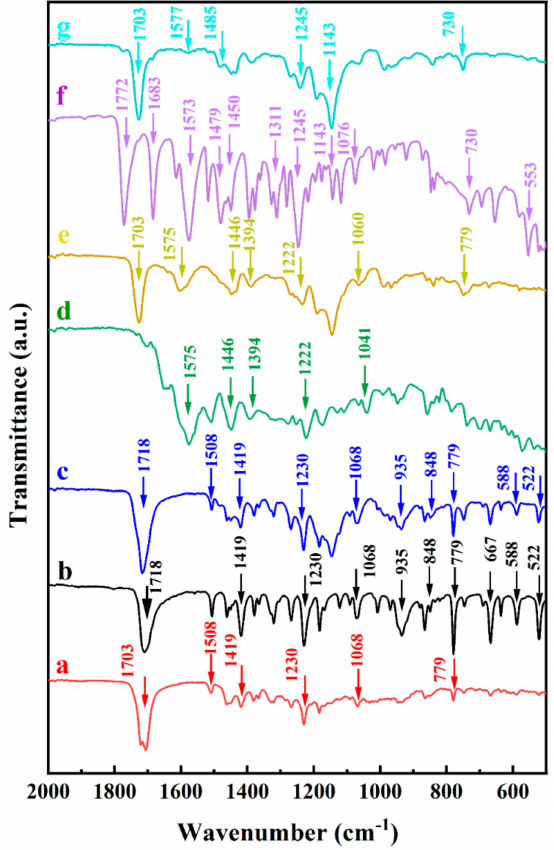
Figure 9. FTIR spectra of ( a ) as-received PMMA ( b ) as-received ibuprofen, ( c ) PMMA-ibuprofen, ( d ) as- received tetracycline, ( e ) PMMA-tetracycline, ( f ) as-received amoxicillin and ( g )